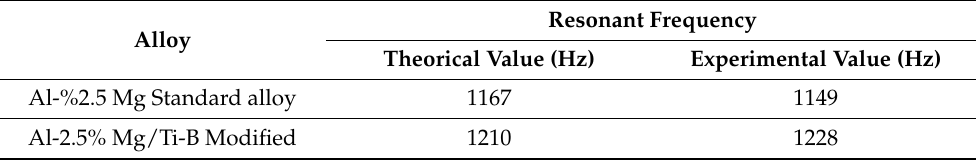
Table 5. Comparison of the theoretical value of the first mode resonance frequency and the experi- mentally measured